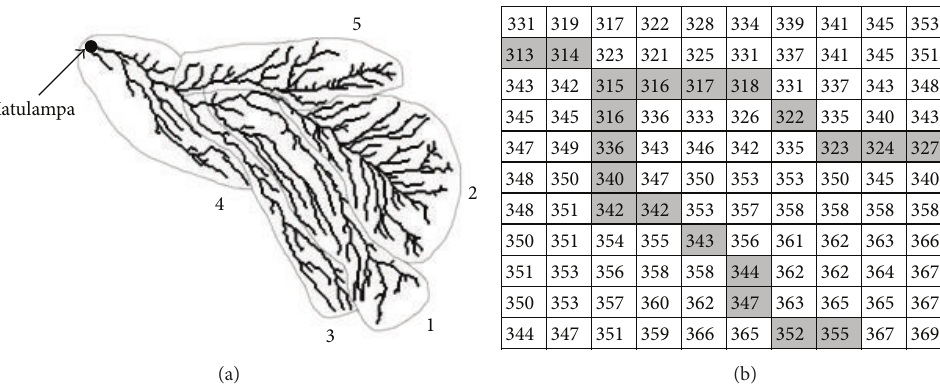
Figure 1: (a) The network pattern of Ciliwung River catchment area which is divided into five regions. The solid dot represents the position of Katulampa observation point. (b) Modified DEM data of 90 × 90 m 2 grid resolution of a small area around